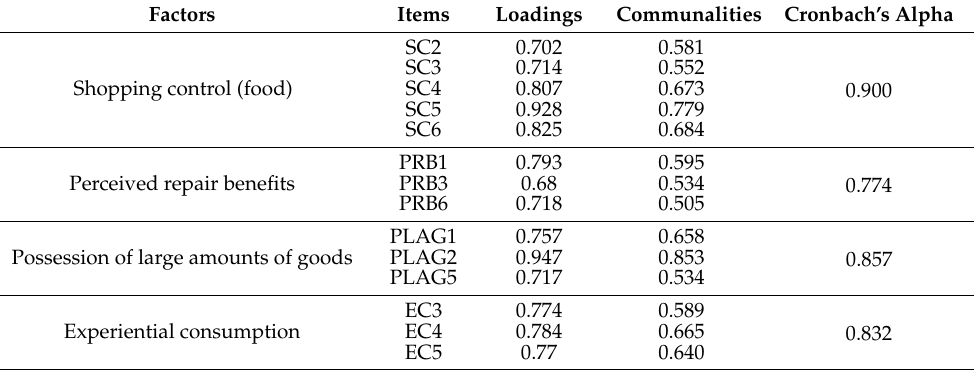
Table 6. Results of